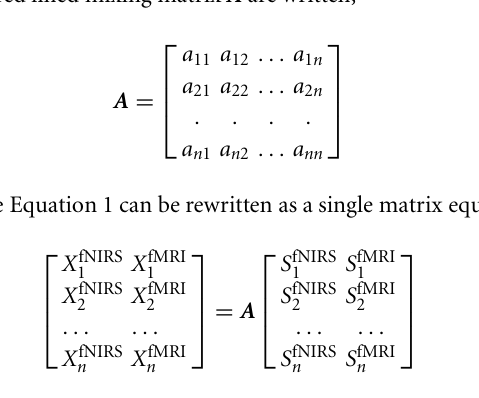
FIGURE 2 | Continued The averaged event-related (cid:2) HbO 2 time course is shown in yellow (the same for all figures) and the (cid:2) HbO 2 component is plotted in cyan. Positive (orange) and negative (blue) Z -values are shown in the image. The axes (bottom) illustrate the time scale, in ms, whereas the scale (left) records chromophore concentrations in μ M for the figures on the left column. The scale for the figures on the right column shows the bold signal intensity. LM, Left primary motor cortex; SMA, Supplementary motor area; P,